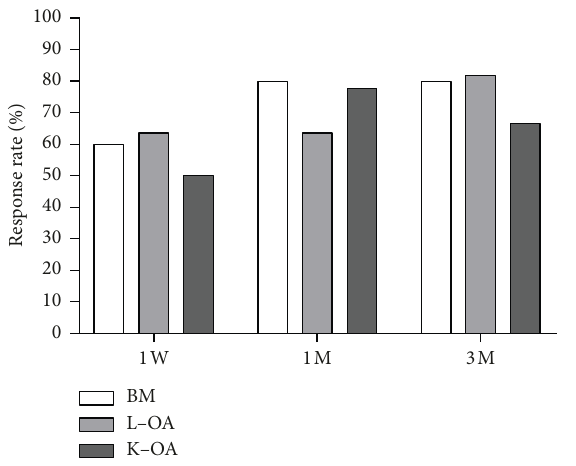
Figure 2: Percentage of patients who responded to treatment at various time points (defined as a > 50% decrease in the pain NRS score). NRS, numerical rating scale; BM, bone metastasis; L-OA, lumbar facet joint osteoarthritis; K-OA, knee osteoarthritis; W, week; M, month.